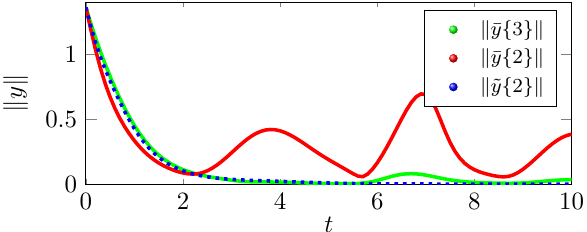
Figure 5. Tracking errors with three different controllers for the rigid body attitude